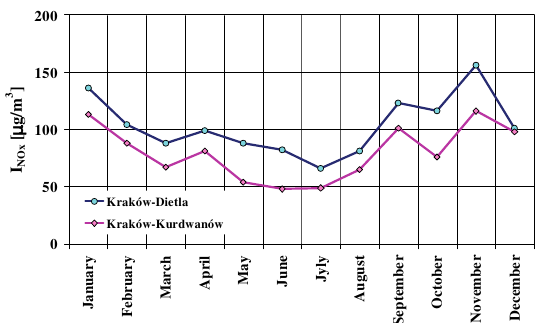
Fig. 11. The immission of nitrogen oxides values obtained from Kraków– Dietla station and Kraków–Kurdwanów station in